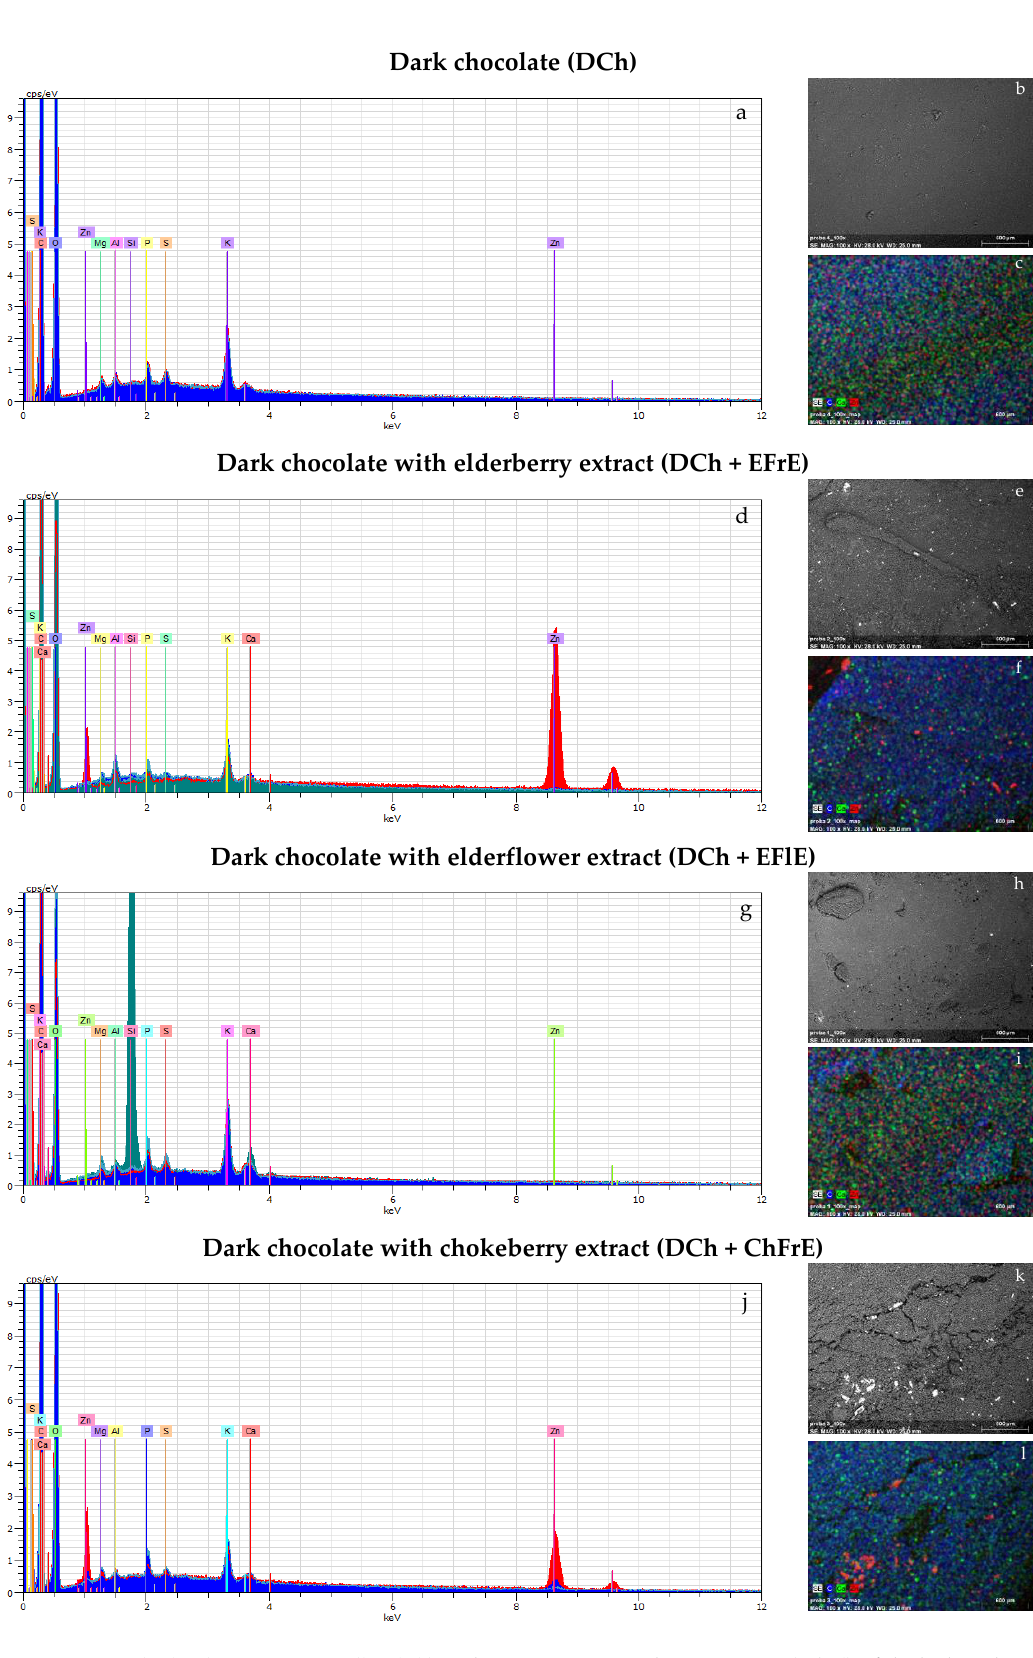
Figure 2. EDS spectra ( a , d , g , j ), SEM images ( b , e , h , k ) and mapping images by SEM–EDS ( c , f , i , l ) of dark chocolates without and with EFrE, EFlE and ChFrE.